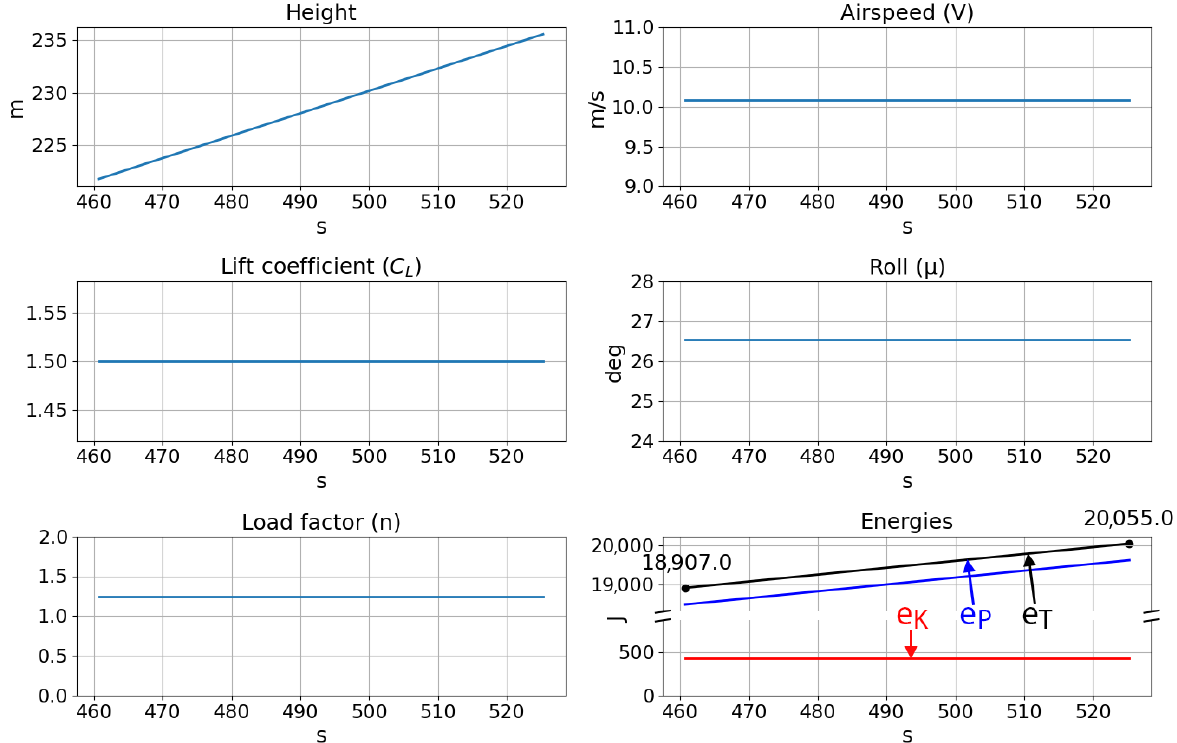
Figure 20. Simulated trajectories of the thermal soaring SUAV neurocontroller.